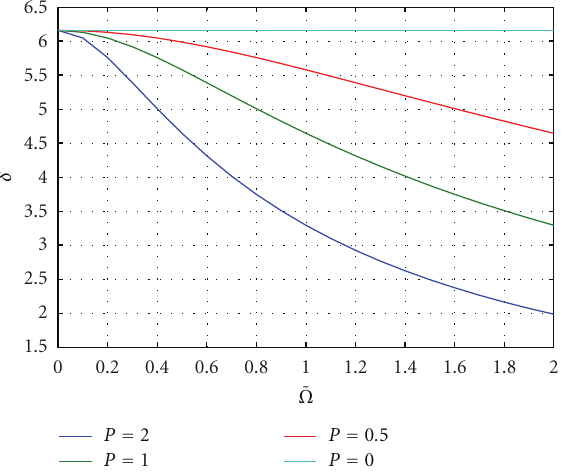
Figure 4: Log decrement as a function of dimensionless running speed, ζ r ,0 = 0 . 7.